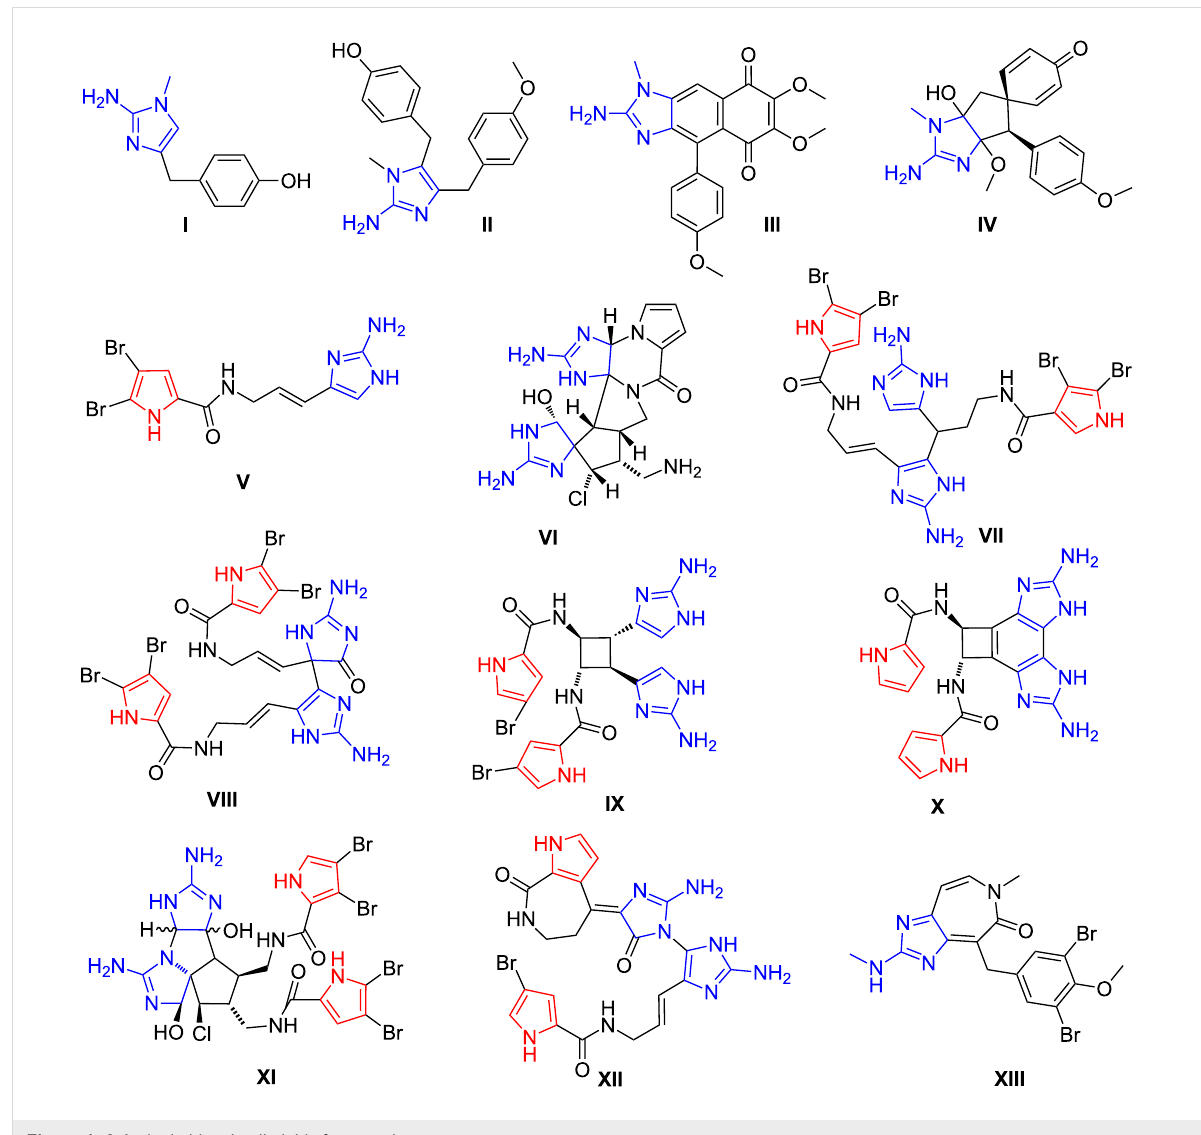
Figure 1: 2-Aminoimidazole alkaloids from marine